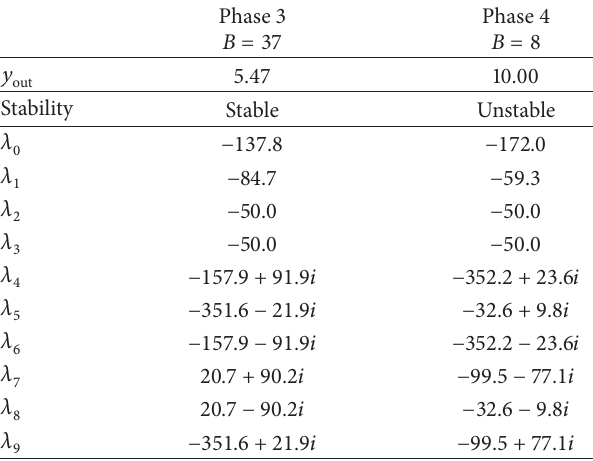
Table 5: Eigenvalues for Phase 3 ( 𝐵 = 37 ) and Phase 4 ( 𝐵 = 8